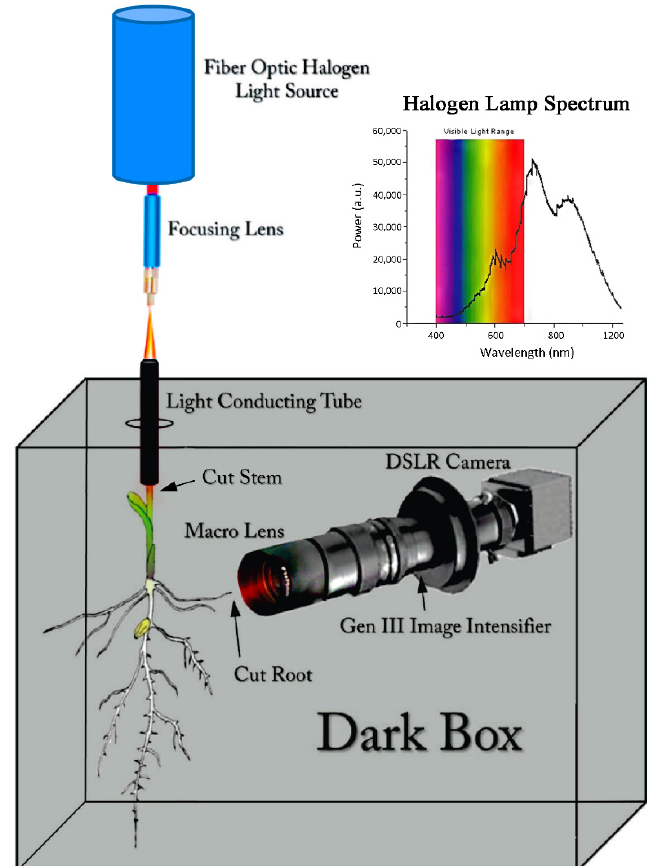
Figure 1. Experimental setup for visualizing light conductance through a maize plant’s stem to its root tip.